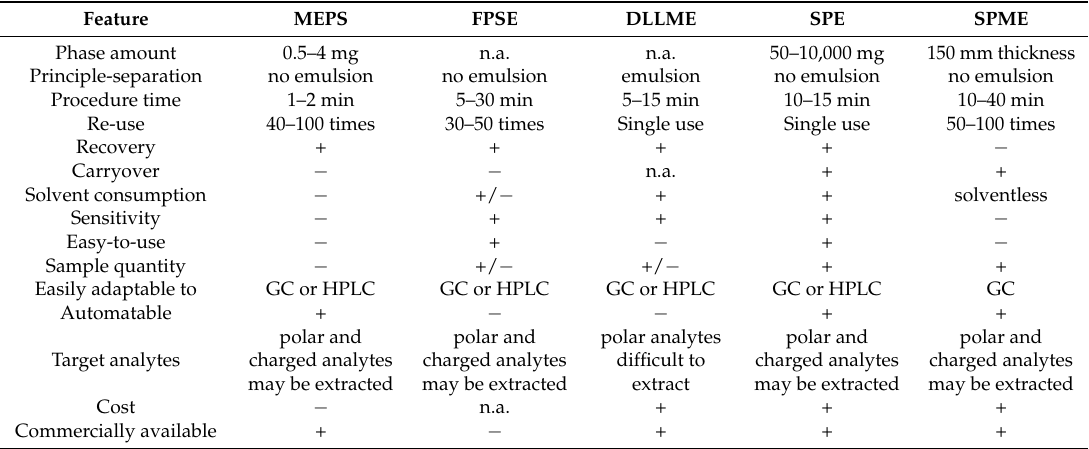
Table 3. A comparison of some characteristics of sample preparation techniques